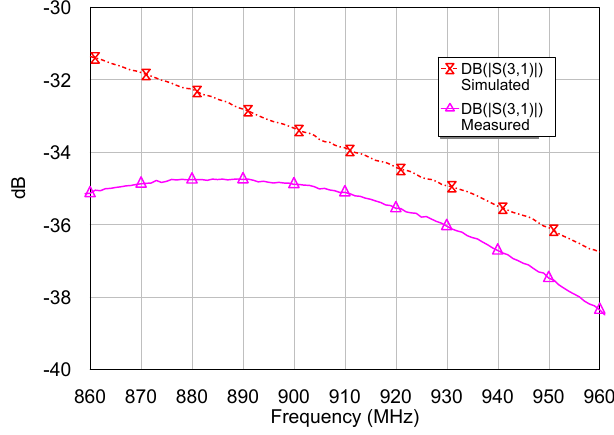
Figure 15. Simulated isolation and experimental result